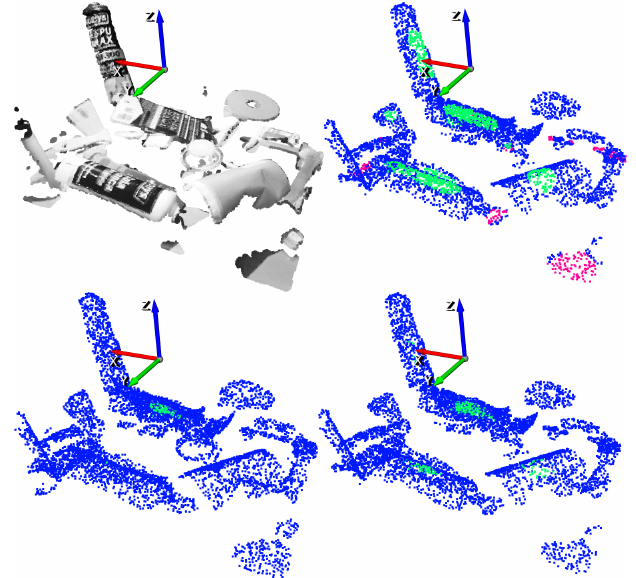
Figure 12. Suction result example. Top-left: Point cloud of the scene. Top-right: Ground-truth annotation. Bottom-left: top-1% predictions. Bottom-right: top-5% predictions.